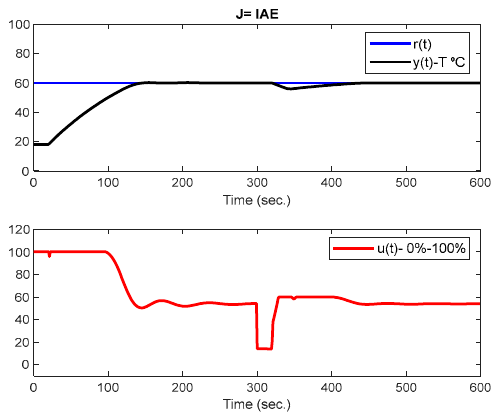
Figure 9. TCLab set-point tracking (SPT) and disturbance rejection (DR) simulated responses with a PID controller optimized with the PSO algorithm (J = IAE).